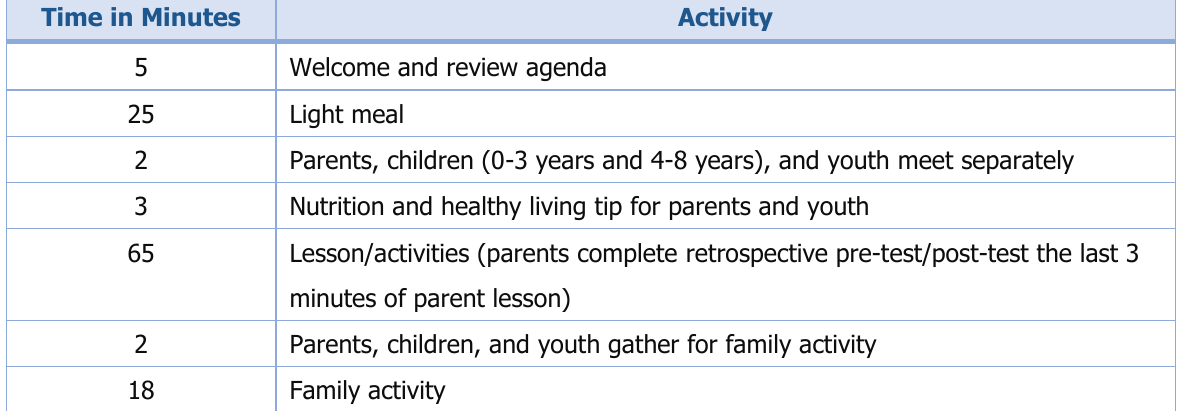
Table B1. Sample Agenda and Meeting Format Time in